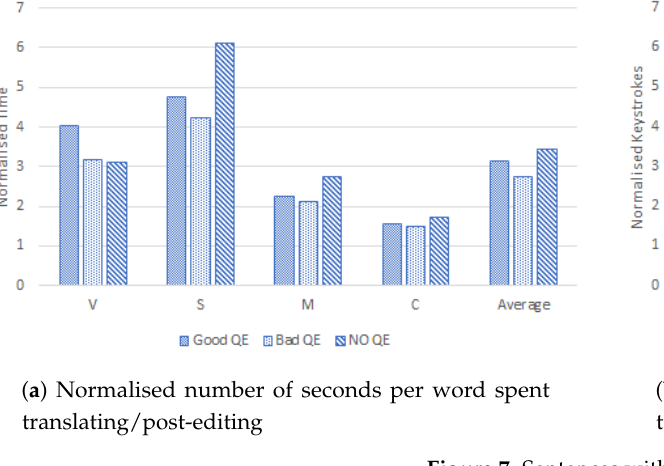
Figure 7. Sentences with FMS ≤